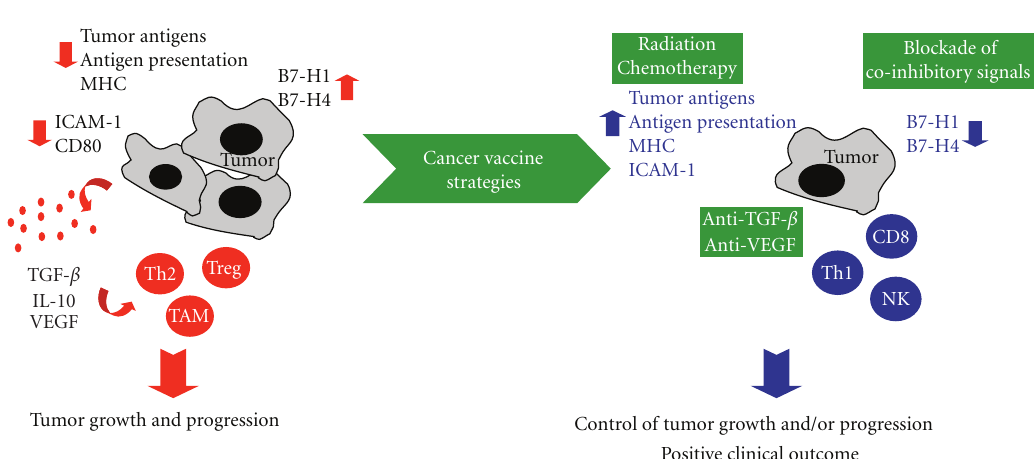
Figure 1: Cancer vaccine strategies aimed at shifting the immune environment of a tumor from protumorigenic to antitumorigenic.